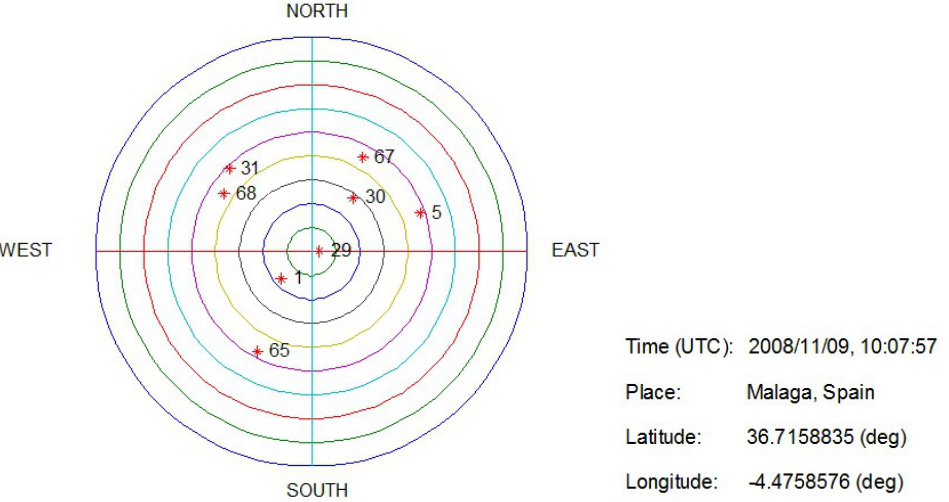
Figure 6. Sky plot of available GPS and GLONASS satellites with the elevation mask angle of 40